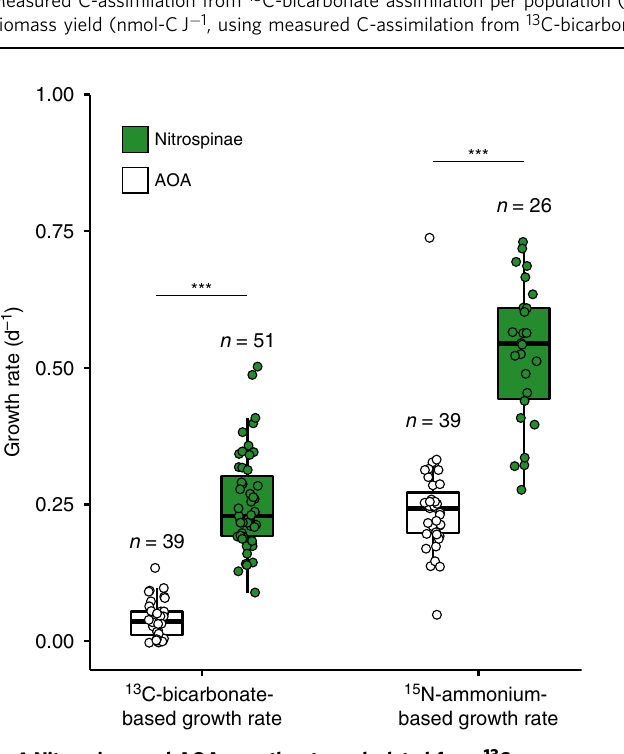
15 N-nitrite, see Methods) to determine single cell Nitrospinae growth rates. Autotrophic growth rates from C- fi xation were 0.25 ± 0.01 (SE) day − 1 and ammonium-based growth rates were 0.53 ± 0.03 (SE) day − 1 (Fig. 4), corresponding to doubling times